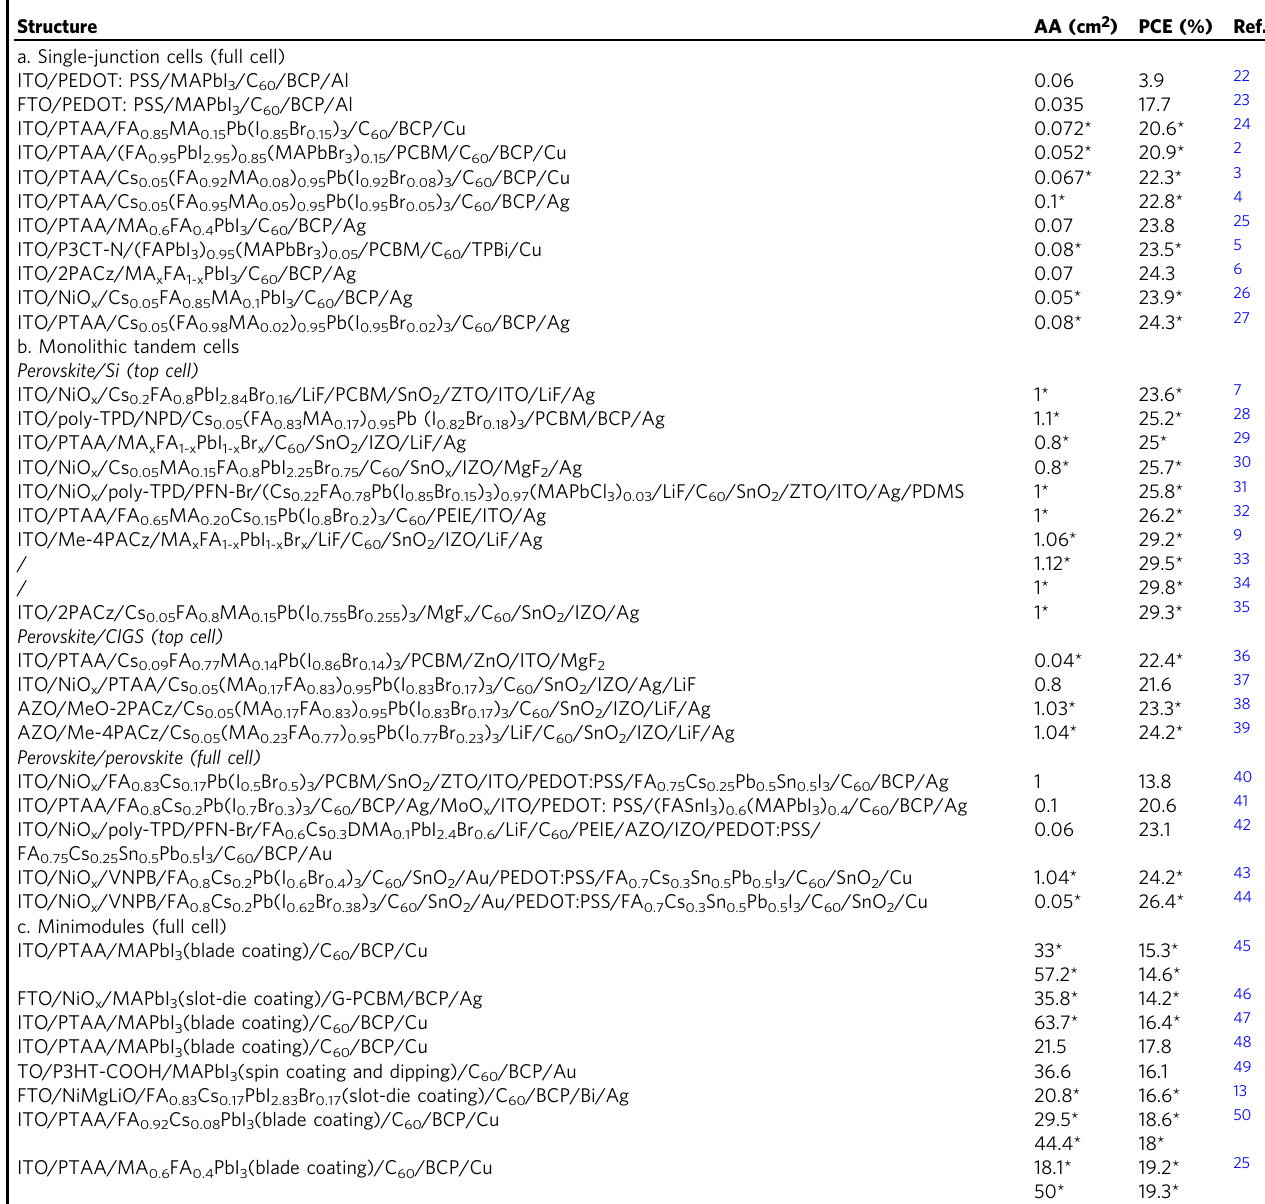
Table 1 The evolution of IPSCs, consisting of small-area single-junction cells, tandem cells, and high-performance perovskite minimodules (over 14% PCEs).